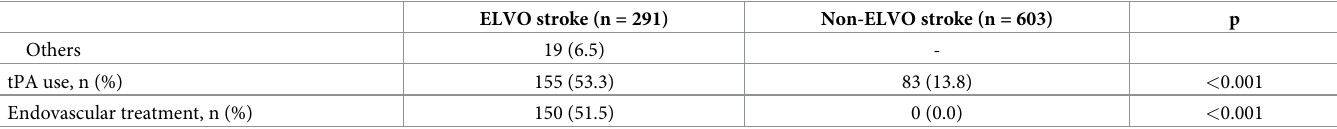
Tier 1: Stroke mimic vs. true stroke: CIVIL- AS 3 A 2 P